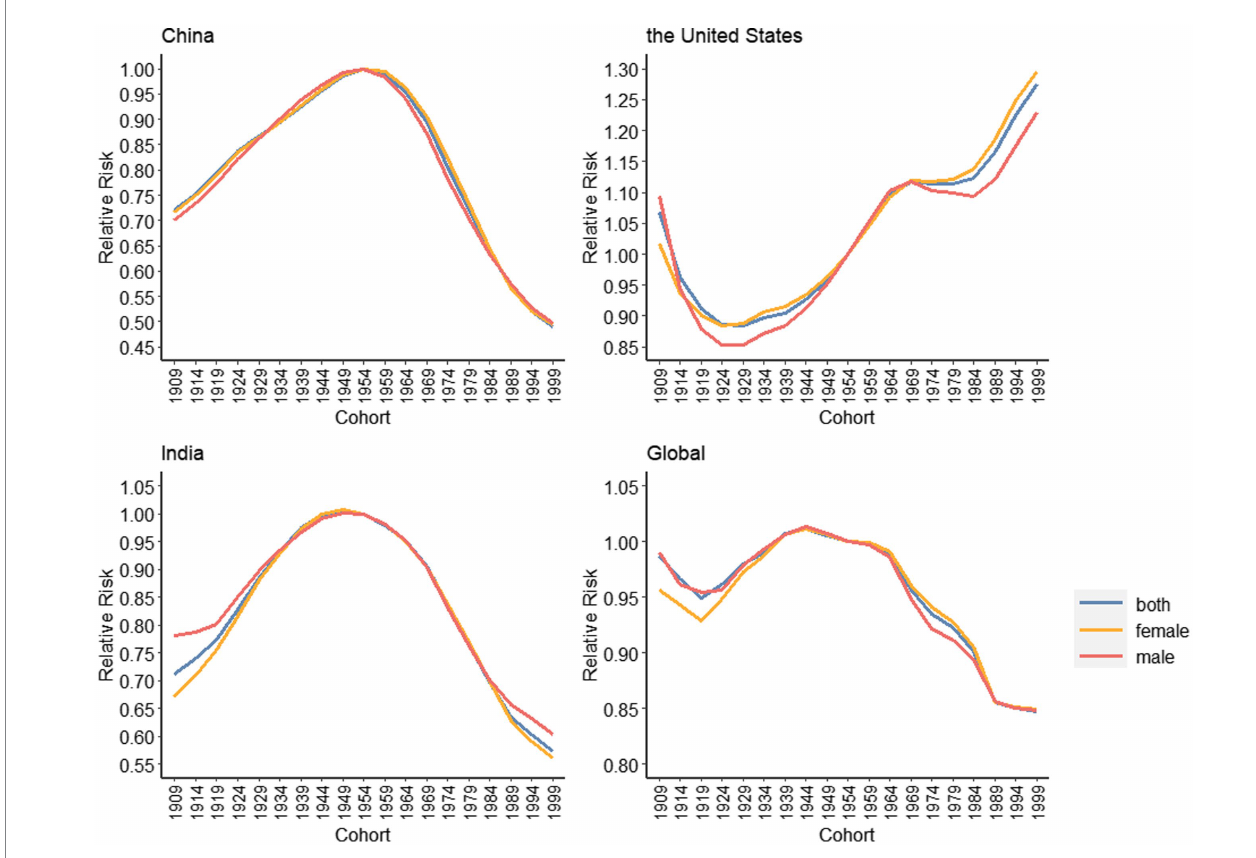
FIGURE 7 Cohort effects on depressive disorders incidence rate for China, the United States, India and the global,